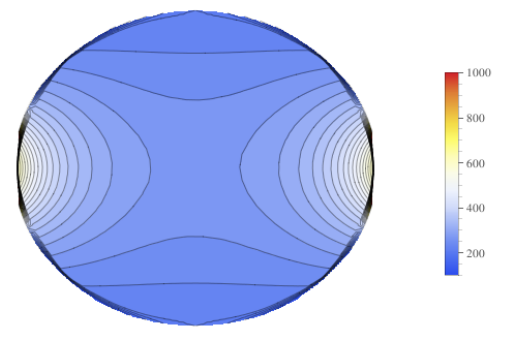
Figure 10. Contour plot of the standard deviation for the electrical field experienced by the